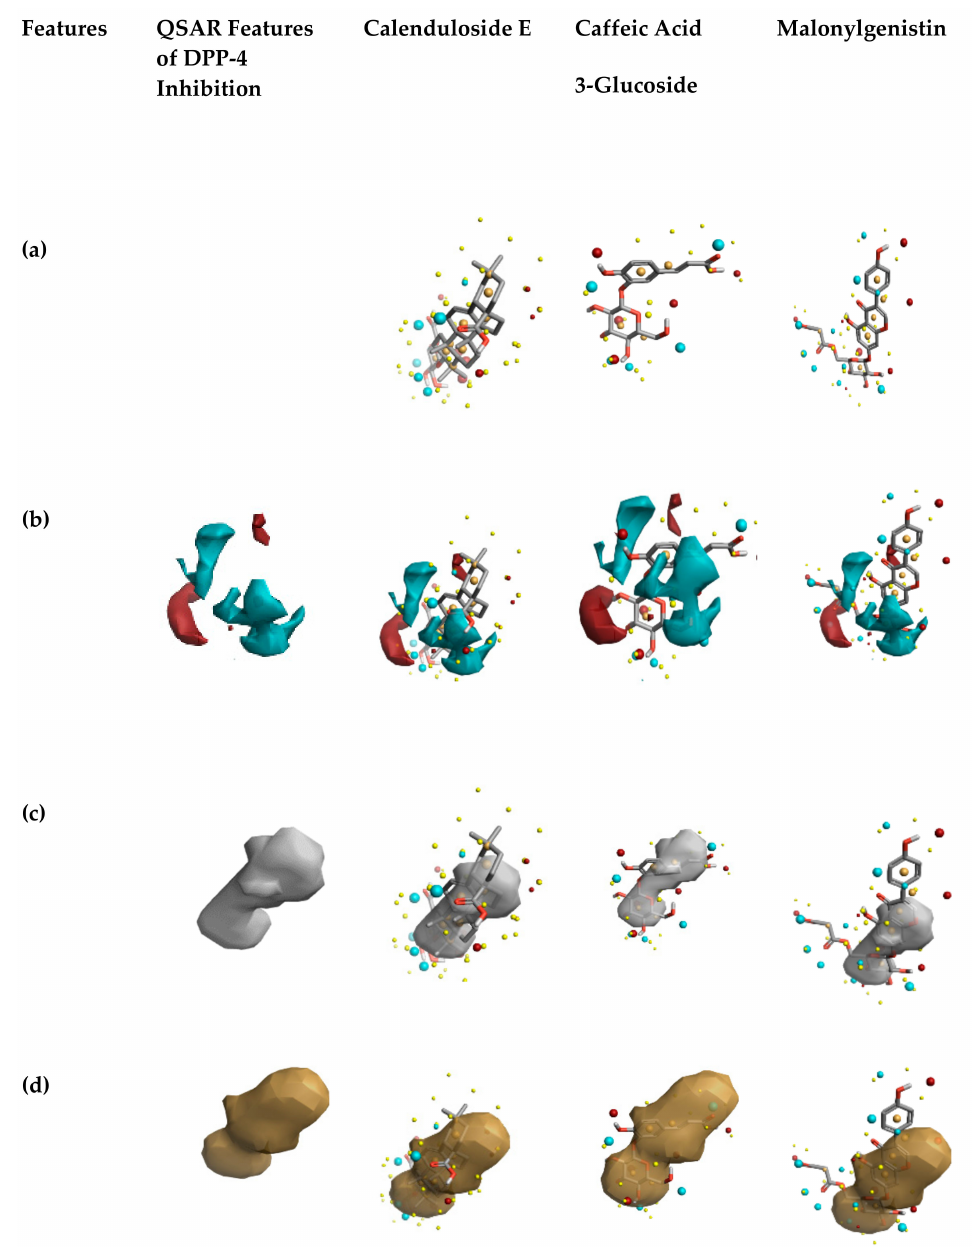
Figure 7. The activity atlas model revealing insights into DPP-4 inhibitory activity. ( a ) 3D structures of phytochemicals identified in garlic bulb extract. ( b ) Activity cli ff summary features of DPP-4 inhibitors and phytochemicals of garlic bulb extract. In this, red color shows the positive electrostatic field, and blue color represents the negative electrostatic field responsible for DPP-4 inhibition. ( c ) Average shapes of activity of DPP-4 inhibitors and natural compounds of garlic bulb extract. ( d ) Average hydrophobics of active shape of natural compounds of garlic bulb extract and DPP-4